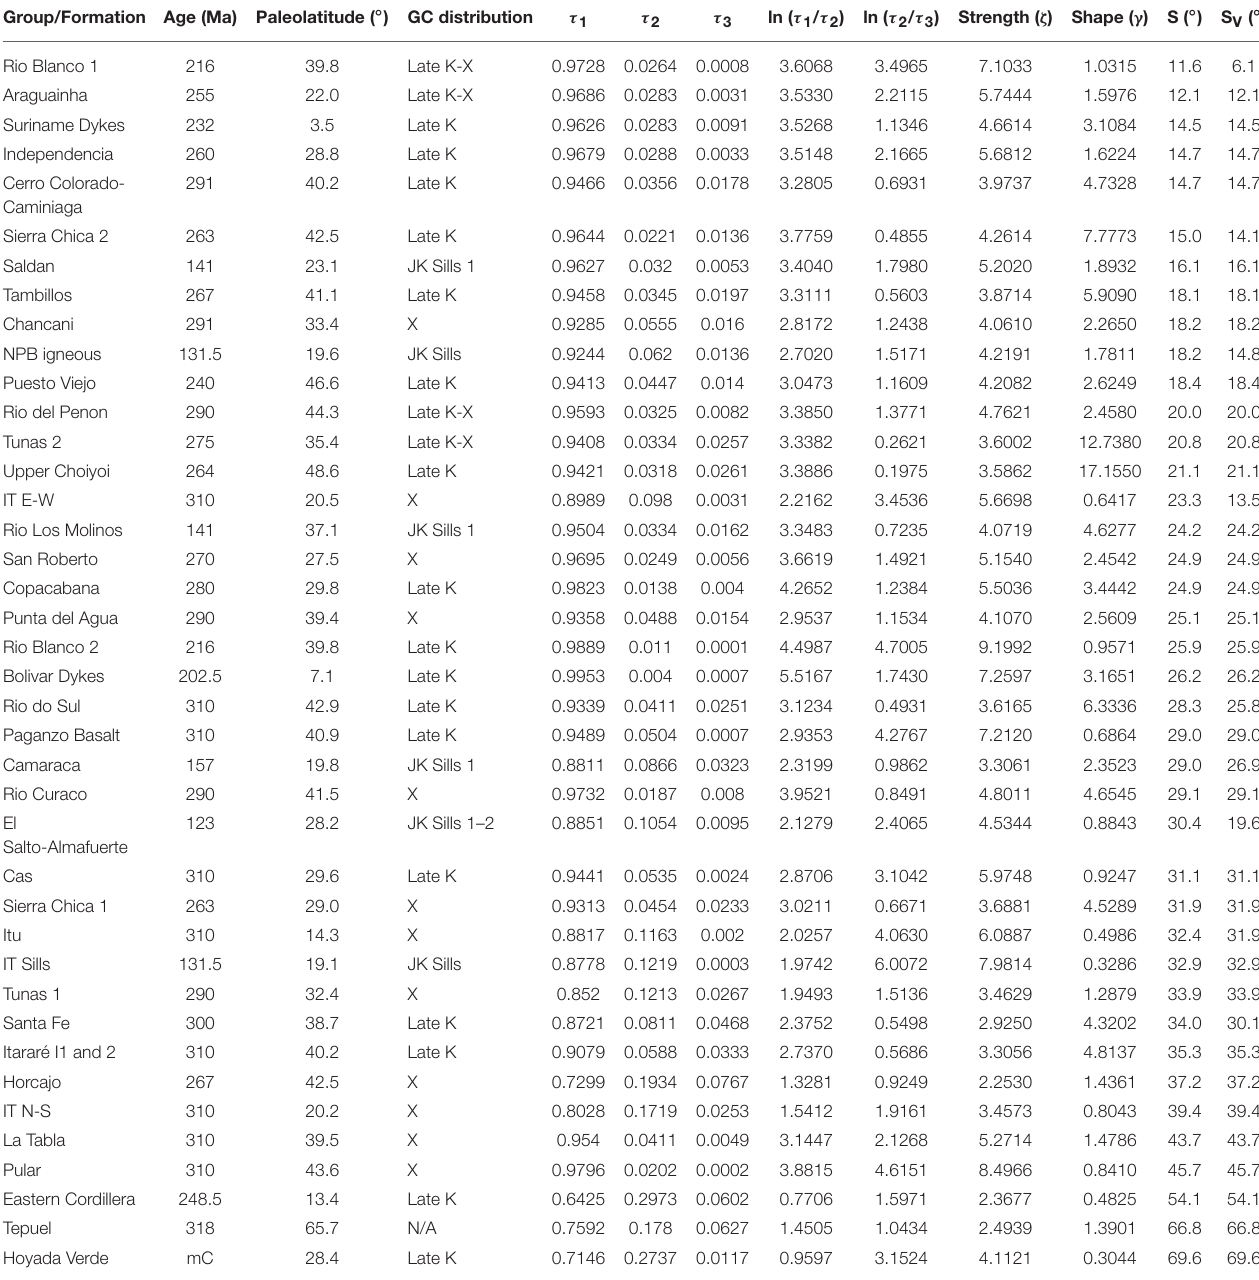
TABLE 3 | Maximum, intermediate and minimum principal components ( τ 1 , τ 2 , and τ 3 , respectively) of the VGP great-circle fits, and calculated shape (g) and strength (z) parameters. Group/Formation Age (Ma) Paleolatitude ( ◦ ) GC